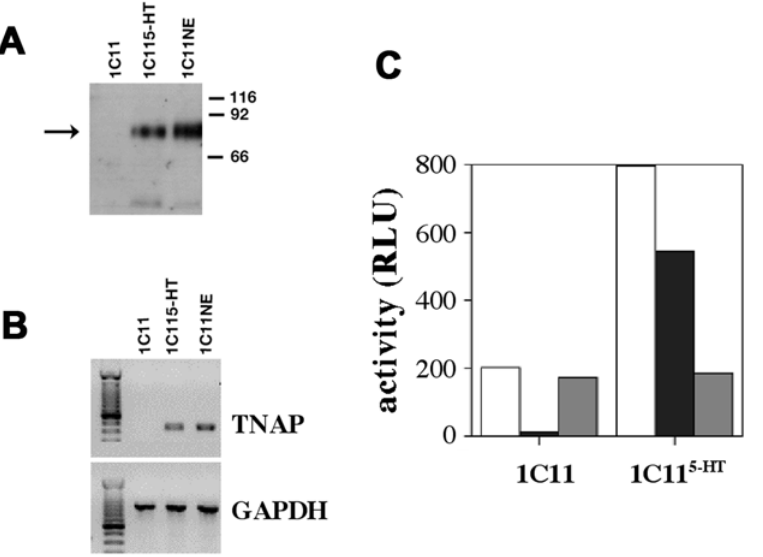
Figure 6. The expression of a functional TNAP is restricted to differentiated serotonergic and noradrenergic 1C11 derived-cells. In (A), the presence of TNAP in 1 m g of lipid rafts prepared from 1C11 induced or not to differentiate was revealed by western blot analysis using an anti- TNAP specific antibody. In (B), the expression of TNAP mRNAs was evaluated by PCR analysis. TNAP (upper panel) or GAPDH (lower panel) specific fragments were obtained after amplification by PCR of cDNA synthesized from mRNA isolated from the 1C11 precursor and the differentiated 1C11 5- HT and 1C11 NE cells. In (C), phosphatase activity at the surface of 1C11 and 1C11 5-HT cells was measured by luminescence using the CSPD substrate and expressed as relative luminescent unit (RLU). White bars correspond to total phosphatase activities, black bars to the activity measured in the presence of 1 mM orthovanadate and grey bars in the presence of 5 mM tetramisol.